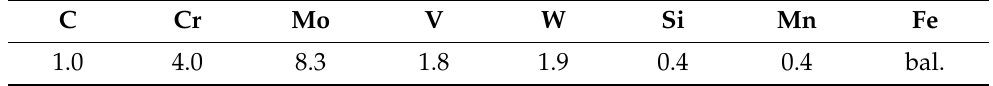
Table 2. Tabular overview of chemical composition of QuFe60 (in wt %).